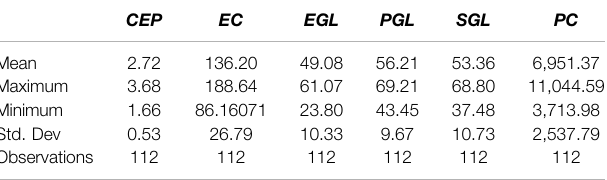
TABLE 4 | Results of KPSS and ERS unit root